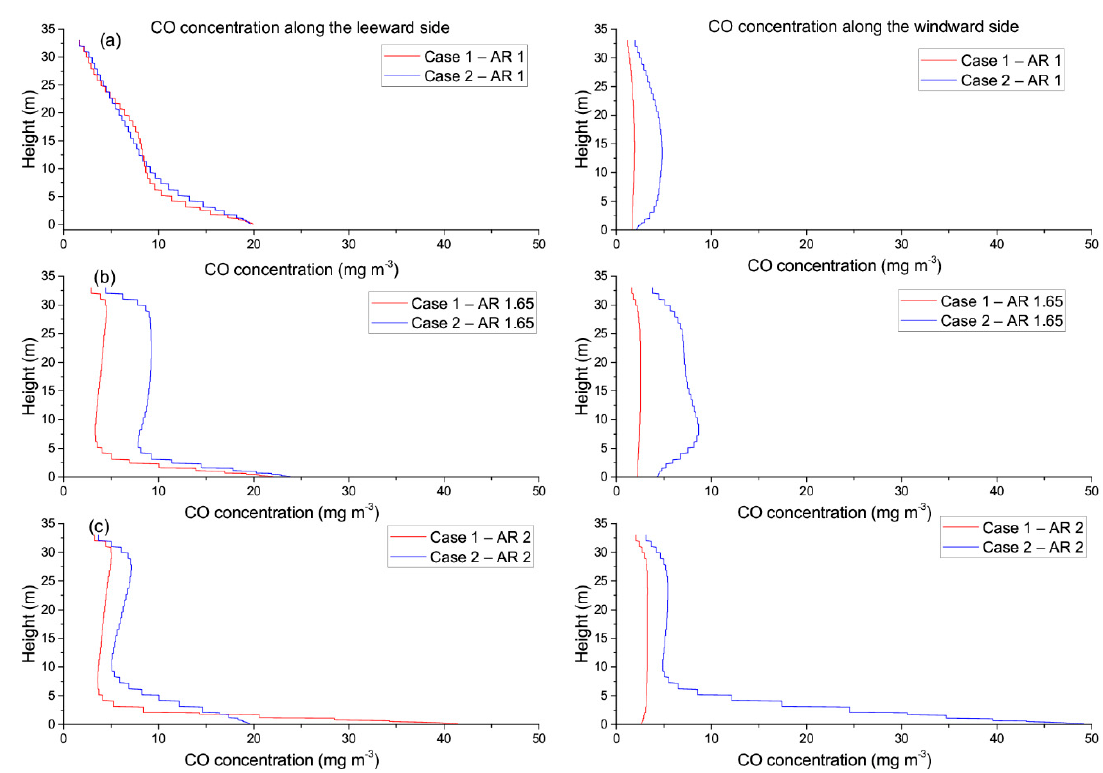
Figure 12. CO concentration profiles within a street canyon with AR equal to 1 ( a ), 1.65 ( b ) and 2 ( c ). Case 1 (red line) and Case 2 (blue line). Vertical profiles are shown by probe lines, one located at 0.5 m from the leeward side (panels on the left) and one on the windward side (panels on the right).